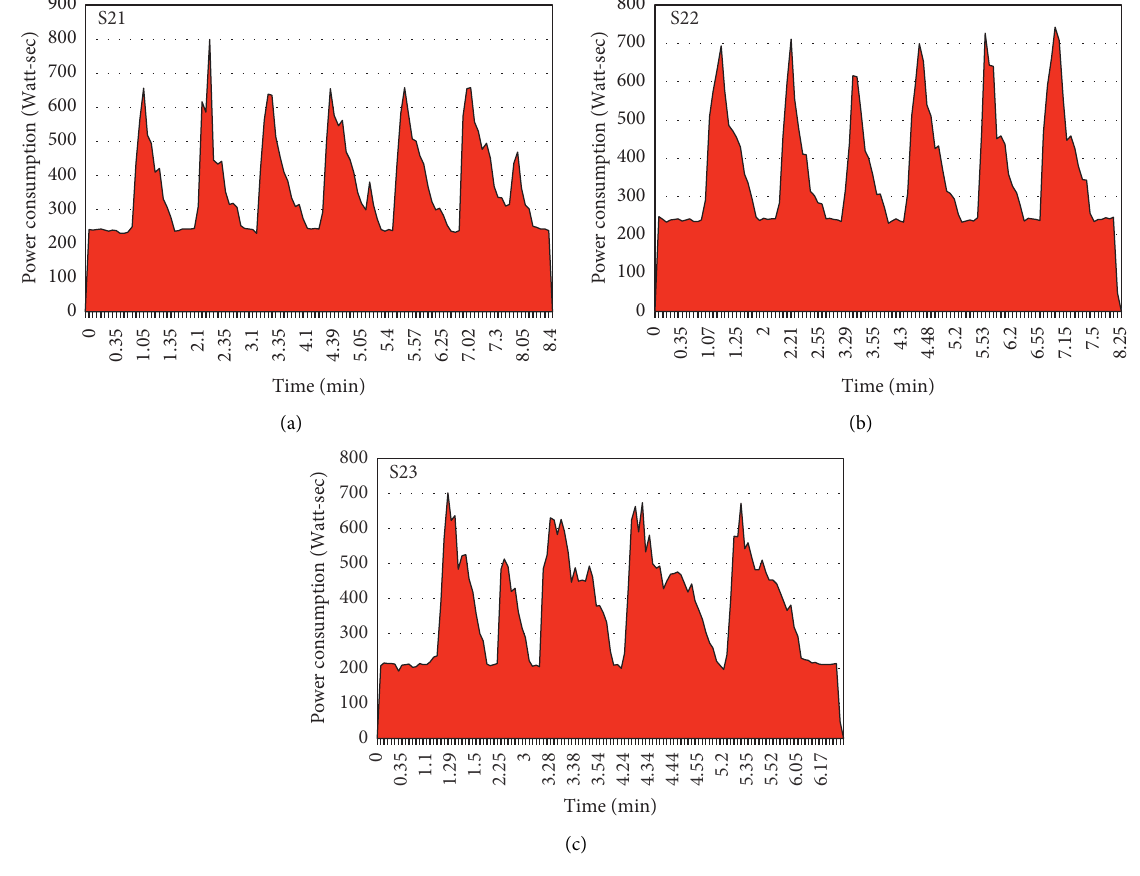
Figure 15: Power consumption curve for M30 grade